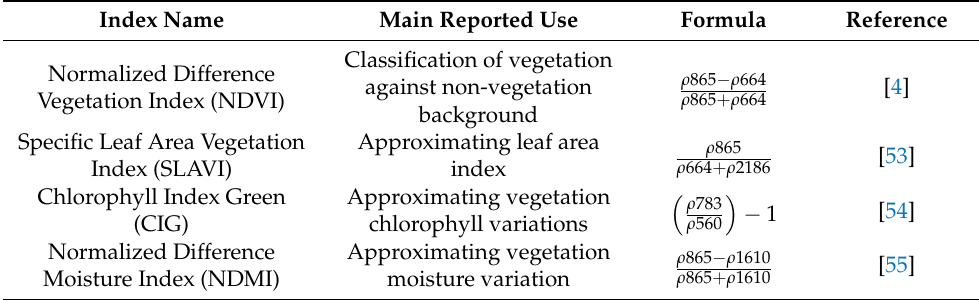
Table 2. Summary of the vegetation indices used in the